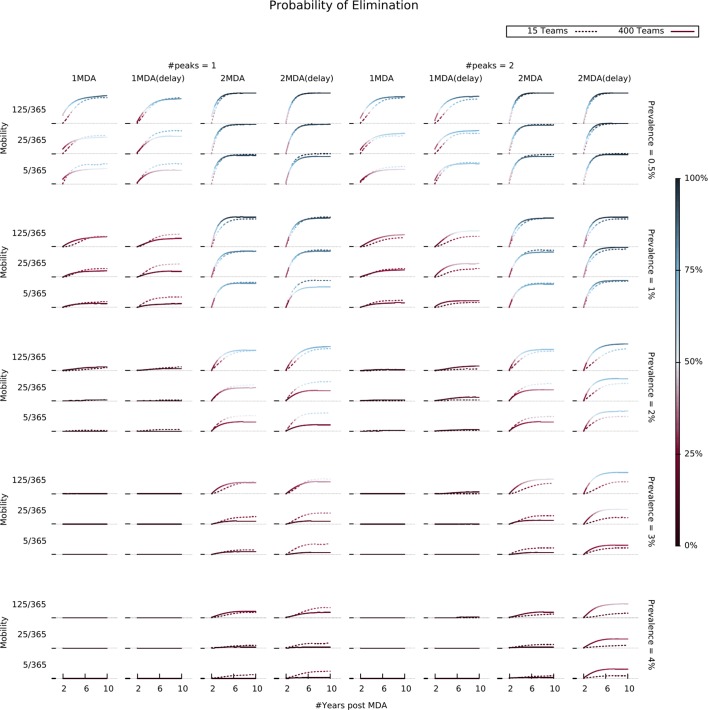
Elimination likelihood over time in different settings.Illustrates the interaction between human population mobility, seasonality patterns, and MDA operational parameters (number of teams and campaign start time). Colors indicate the proportion of simulations in which elimination was reached for each parameter combination, evaluated at different time points.